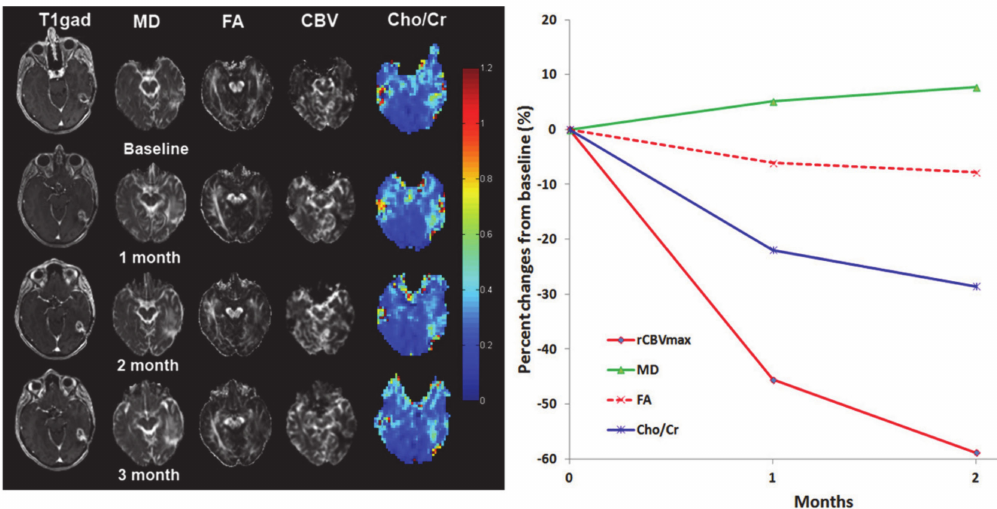
Figure 11. Representative baseline and follow-up anatomical images and parametric maps at baseline and follow-up periods from a patient treated with epidermal growth factor receptor deletion mutation (anti-EGFRvIII) chimeric antigen receptor T cell therapy. Percentage changes in parameters from baseline to 1-, and 2-month follow-up periods from this patient are shown. Reprinted with permission from ref. [115]. Copyright 2019 Springer